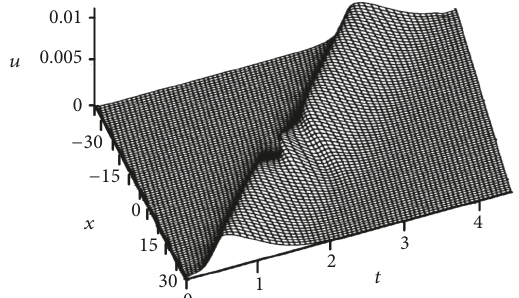
Figure 3: The shape of approximated solution 𝑢 app = 𝑢 3 in the conventional case ( 𝛾 = 1 ). It is plotted with respect to different fixed values of time and space at 𝑘 = 2.5 , 𝑑 = 4.0 , 𝜁 = 0.5. The motion is quite standard and regular.